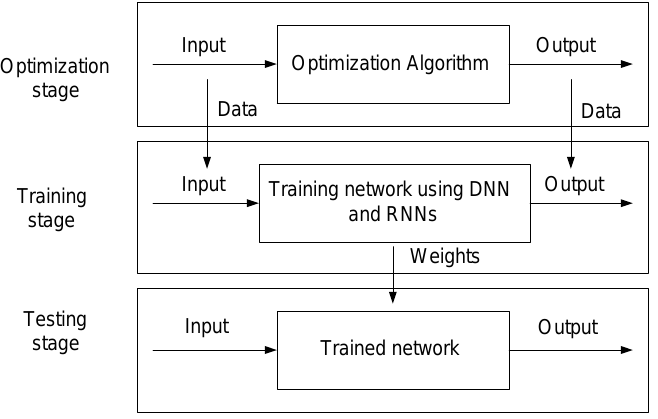
Figure 2. The proposed deep learning-based